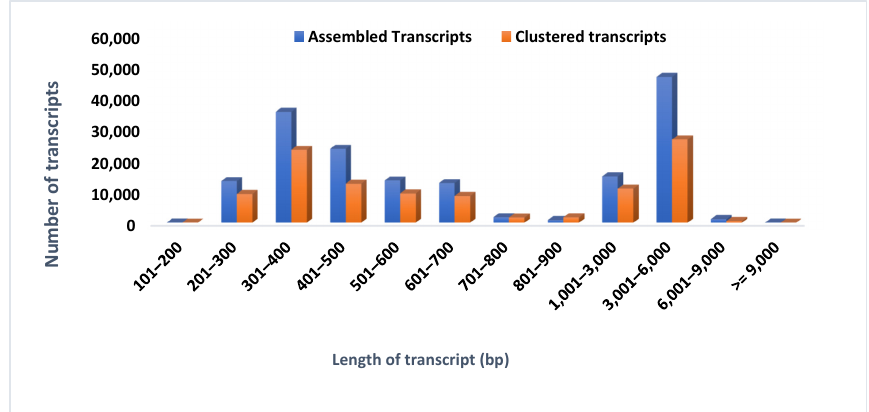
Figure 10. Sequence characterization of assembled and clustered transcripts of sorghum.